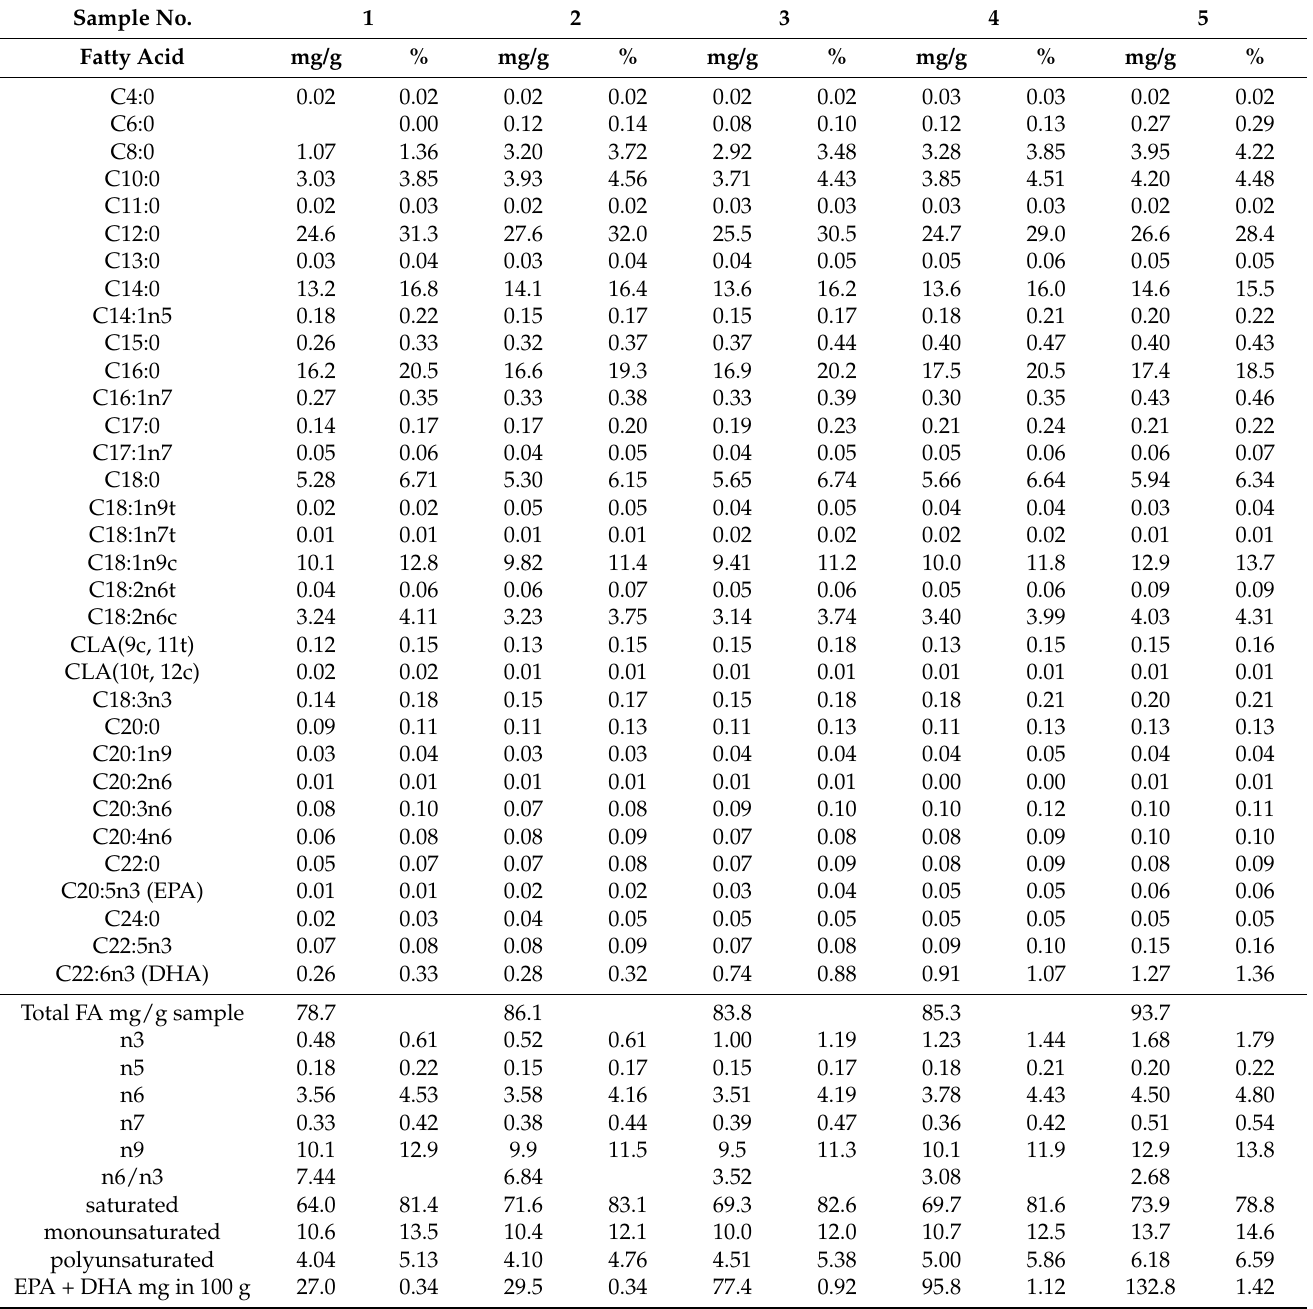
Table 5. Fatty acid profile (quantitative (mg/g product) and qualitative (%)) of the enriched milkshake sample